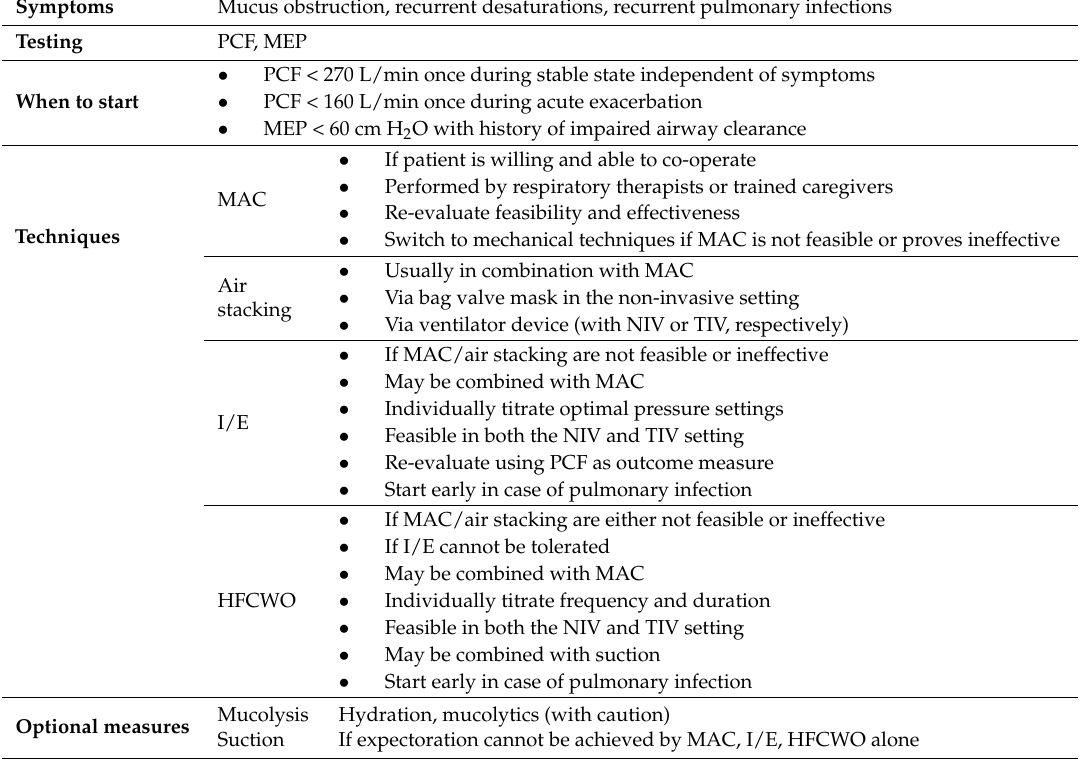
Table 3. Practical recommendations for cough assistance in patients with LOPD. MAC, manually assisted coughing; I/E, insufflation/exsufflation; HFCWO, high frequency chest wall oscillation; NIV, non-invasive ventilation; TIV, tracheostomy invasive ventilation; PCF, peak cough flow; MEP, maximal expiratory